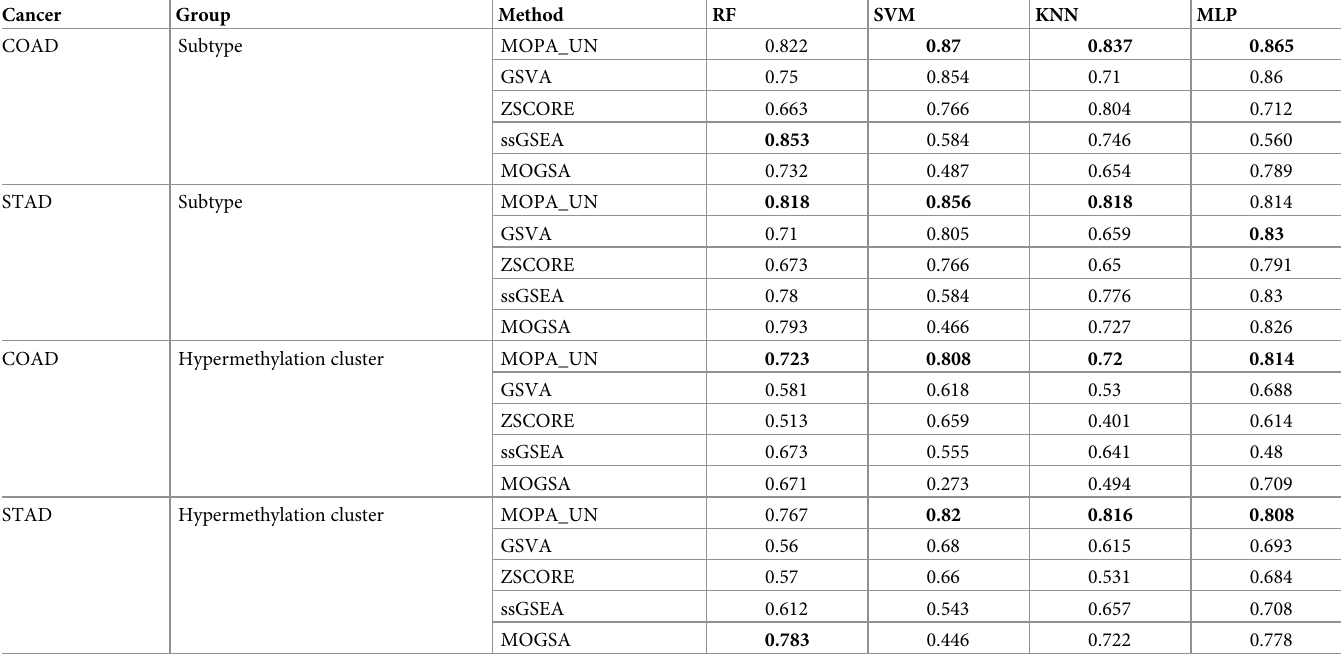
Table 3. The F1-score for classifying molecular subtypes in COAD and STAD were measured using four different classification methods. Cancer